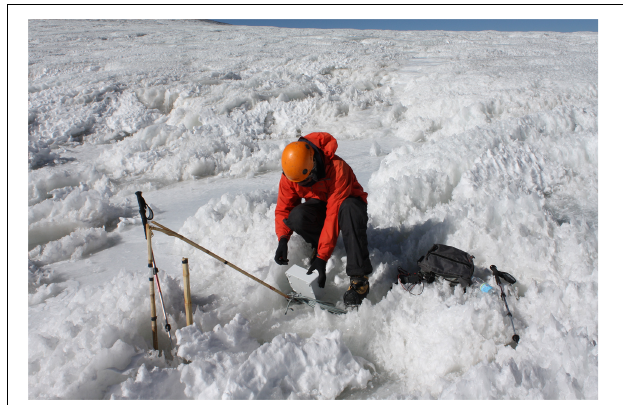
FIGURE 8 | Photograph of Guanaco Glacier at the ice coring location, showing the presence of small penitents on the surface (March 12, 2010).